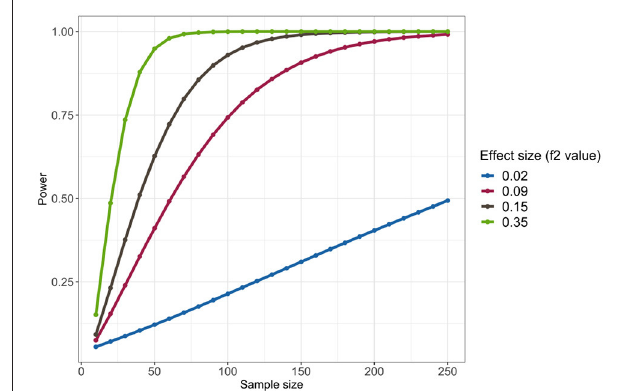
FIGURE 4 | Power analysis of the linear regression model comparing Stroop task reaction time related to positive words among three groups: healthy controls, depressed controls, and depressed suicide attempters, under the significance level 0.05.